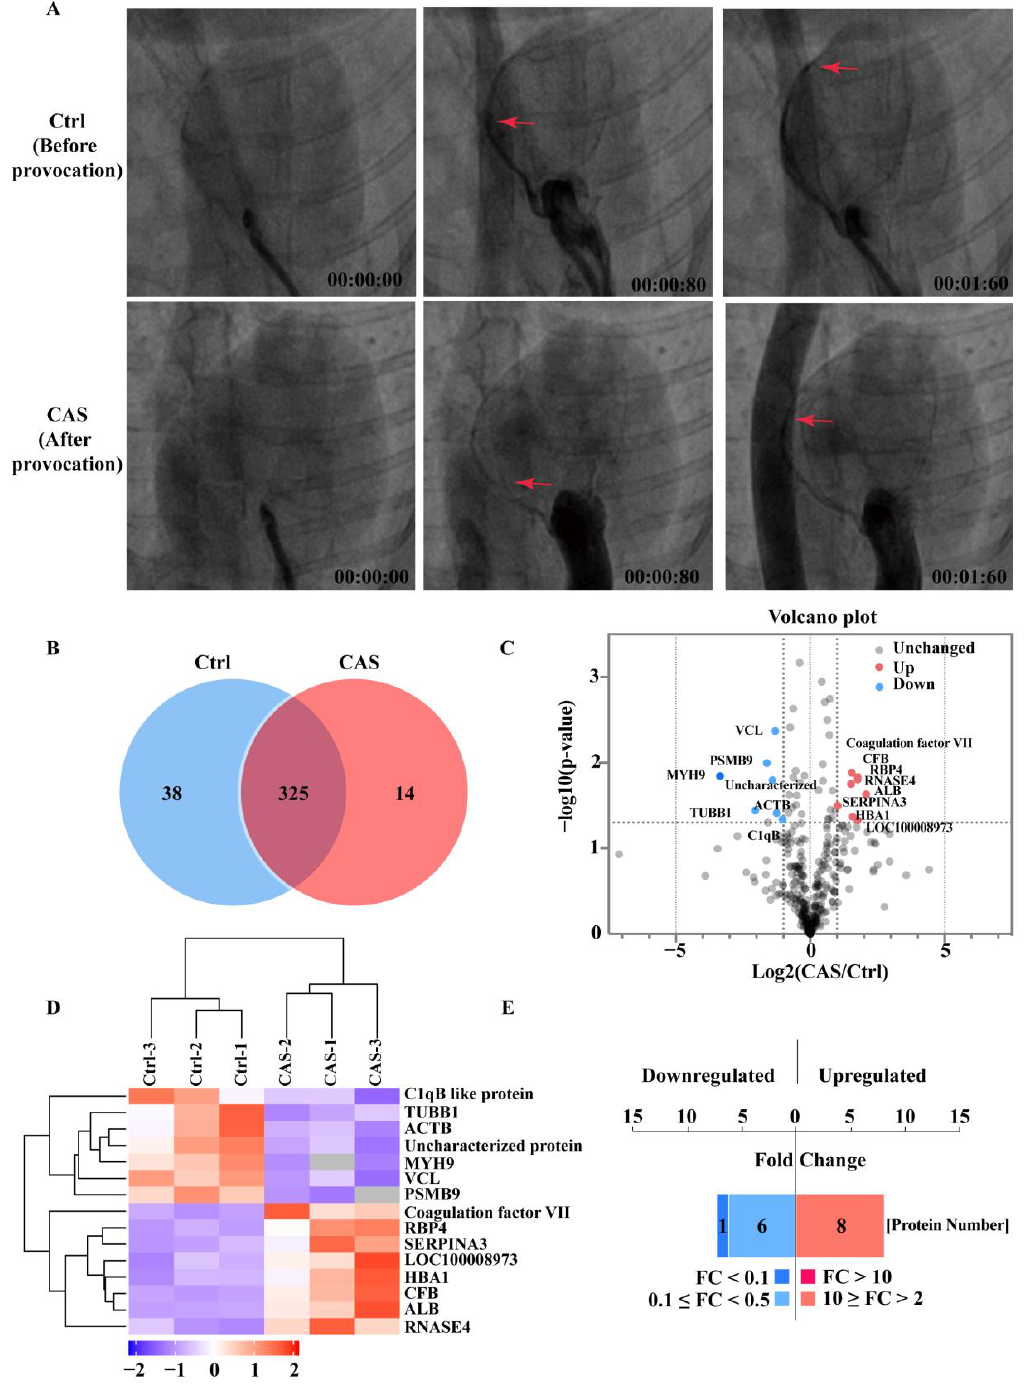
Figure 1. Serum proteome identified multiple dysregulated proteins in the rabbit coronary artery spasm (CAS) provocation model. ( A ) Representative coronary angiogram showing the blood flow before (Ctrl) and after (CAS) pituitrin intracoronary provocation. Red arrows indicate the blood flow at the indicated time points. Time = minute: second: millisecond. ( B , C ) Venn and volcano plots showing the distribution of identified serum proteins. Fifty-two proteins were specifically expressed, while 325 proteins were shared by both groups of the serum. ( D ) At a threshold of fold-change ≥ 2 and p value < 0.05, 15 proteins were identified as significantly differential proteins and are shown in a hierarchical clustering heat map. ( E ) A bar chart showing the fold-change distribution of the 15 significantly differential